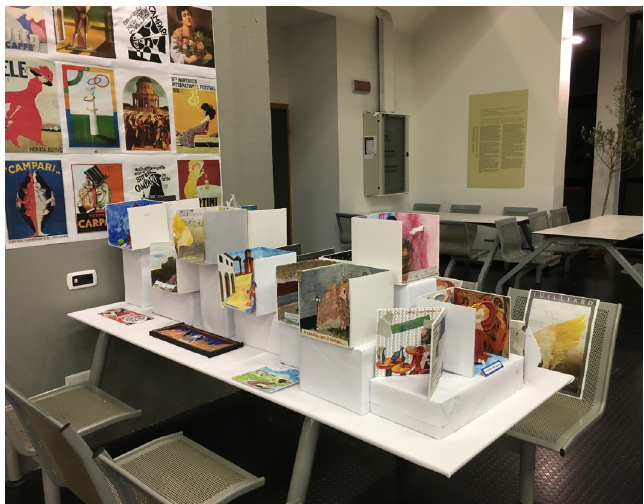
Fig. 4 Talking figure work